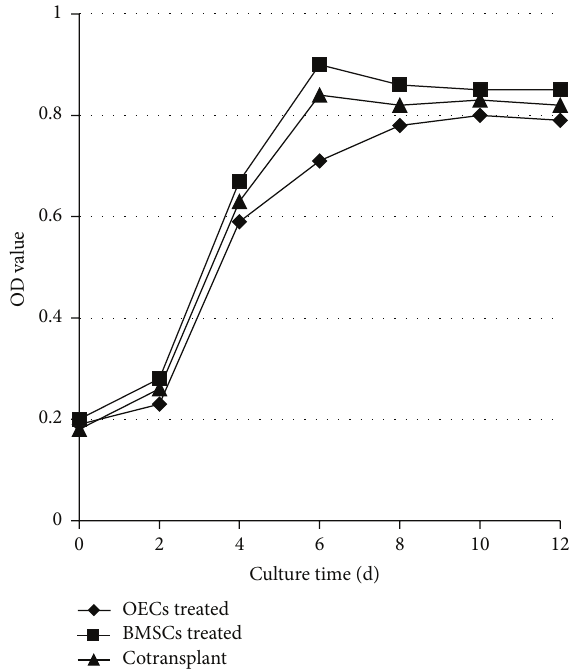
Figure 3: The growth curve of OECs, BMSCs, and coculture